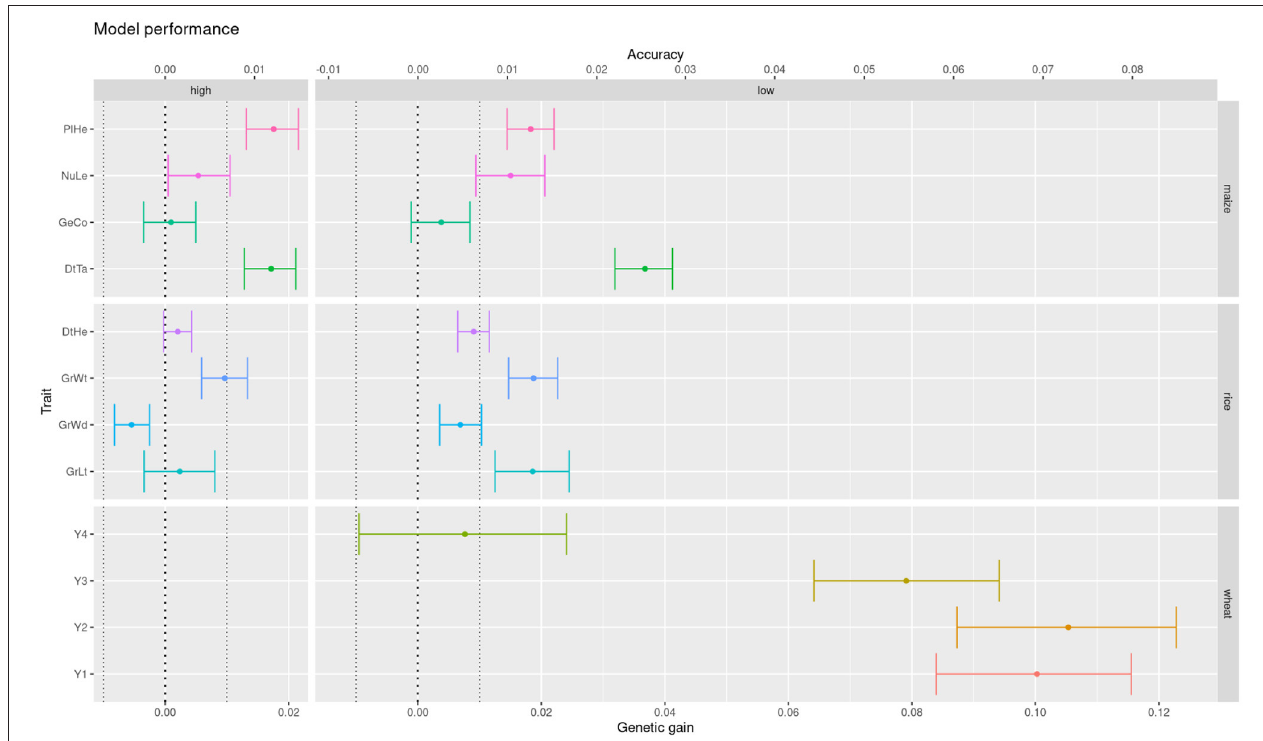
FIGURE 6 | Difference in expected genetic gain from using a Gaussian kernel with respect to a GBLUP prediction model, for low and high panel densities, across multiple crops and traits (color coded for